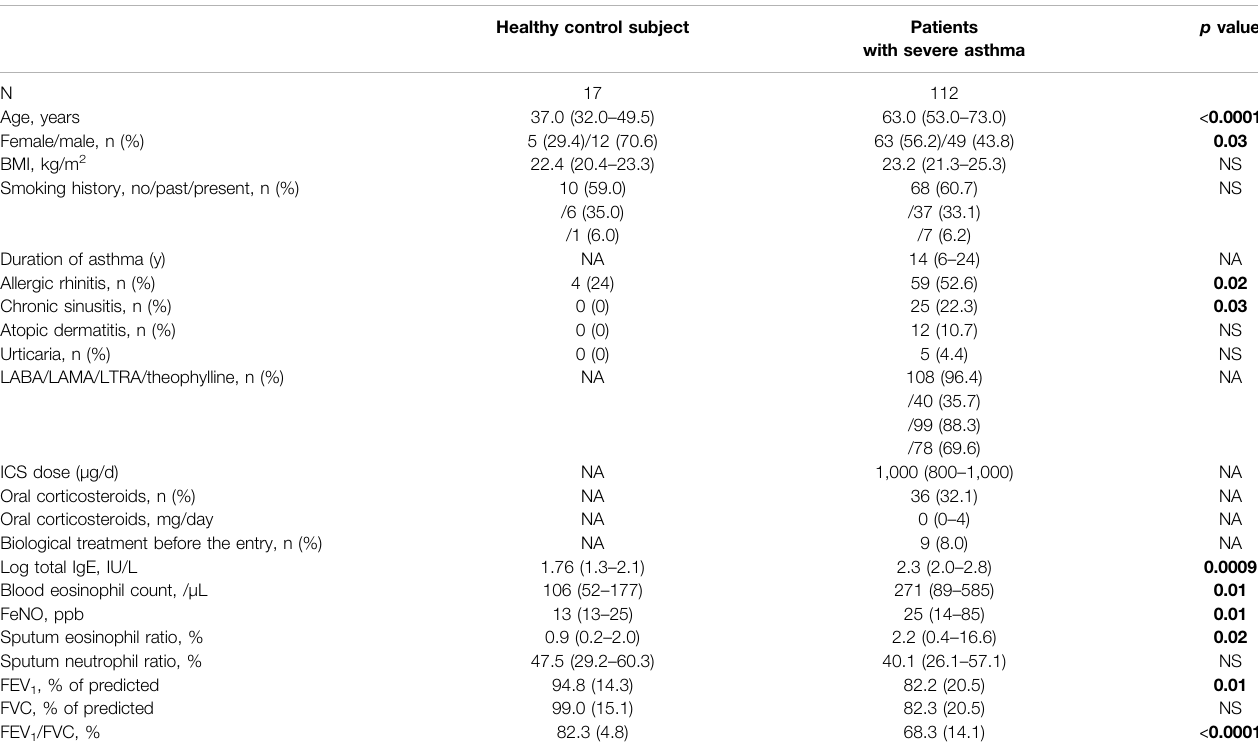
TABLE 1 | Demographic and clinical characteristics of the patients at entry.